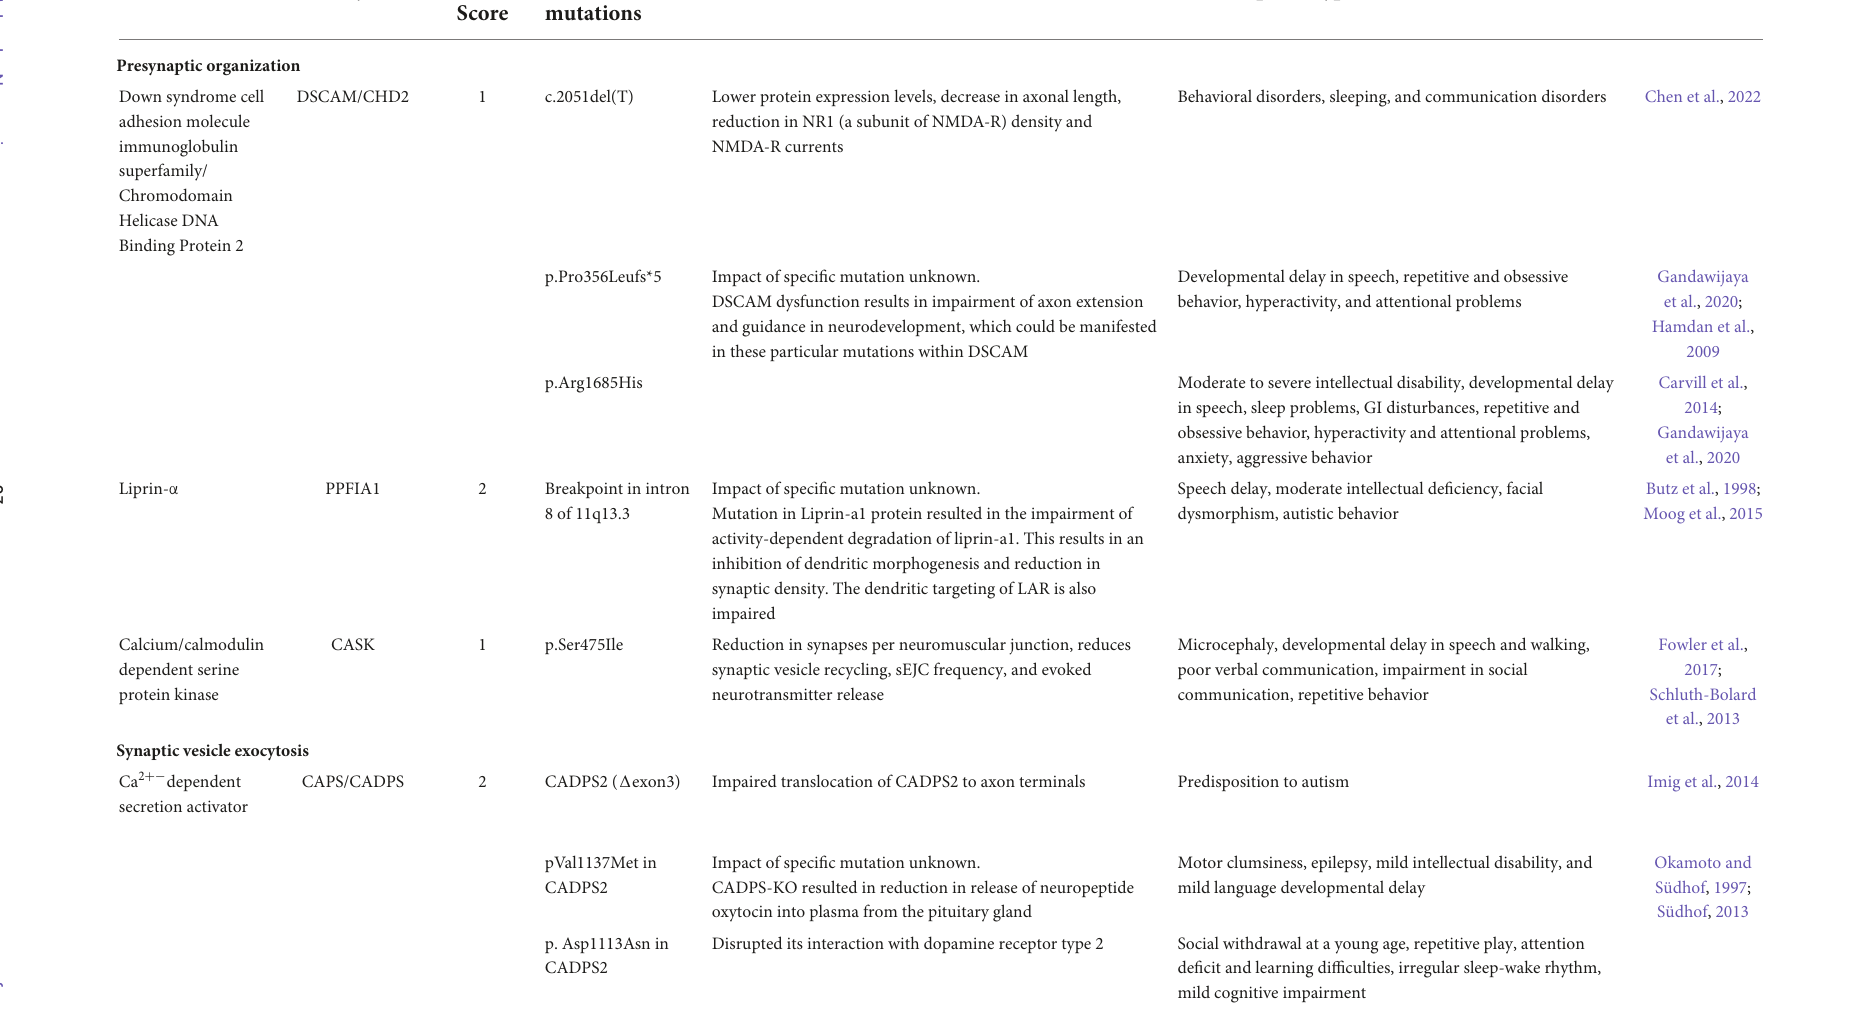
TABLE 1 Autism-associated mutations in presynaptic